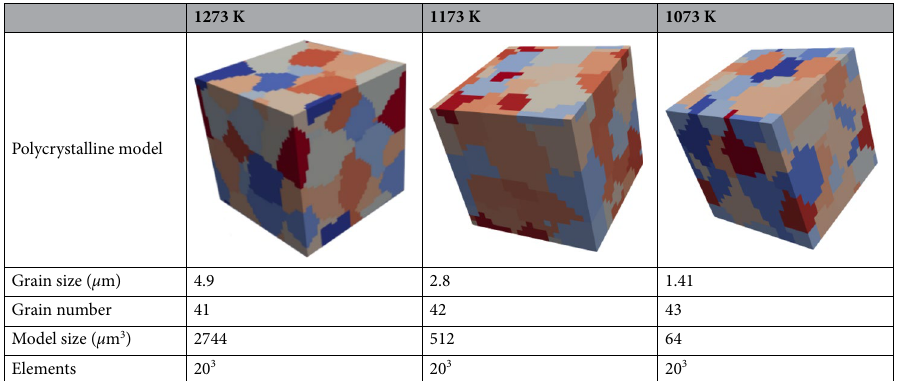
Table 2. Polycrystalline models (Dream 3D analysis).